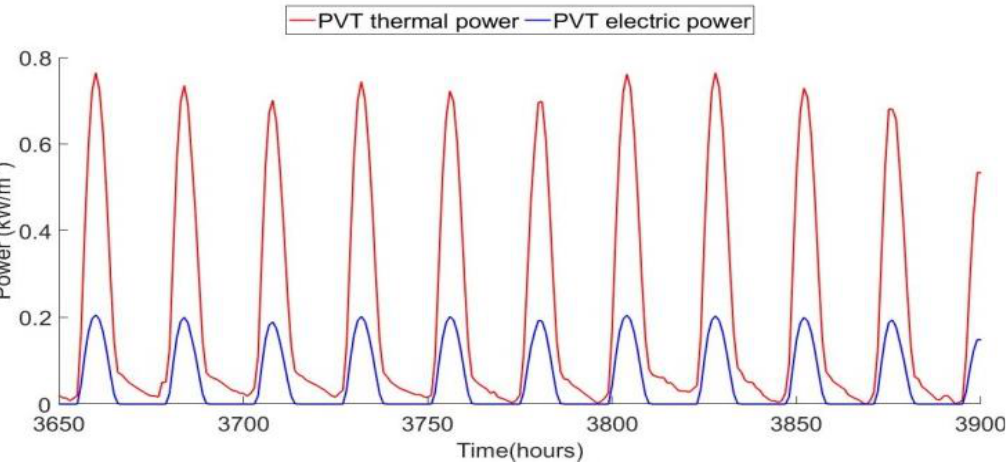
Figure 9. Hourly PVT thermal and electric power production for summer days.